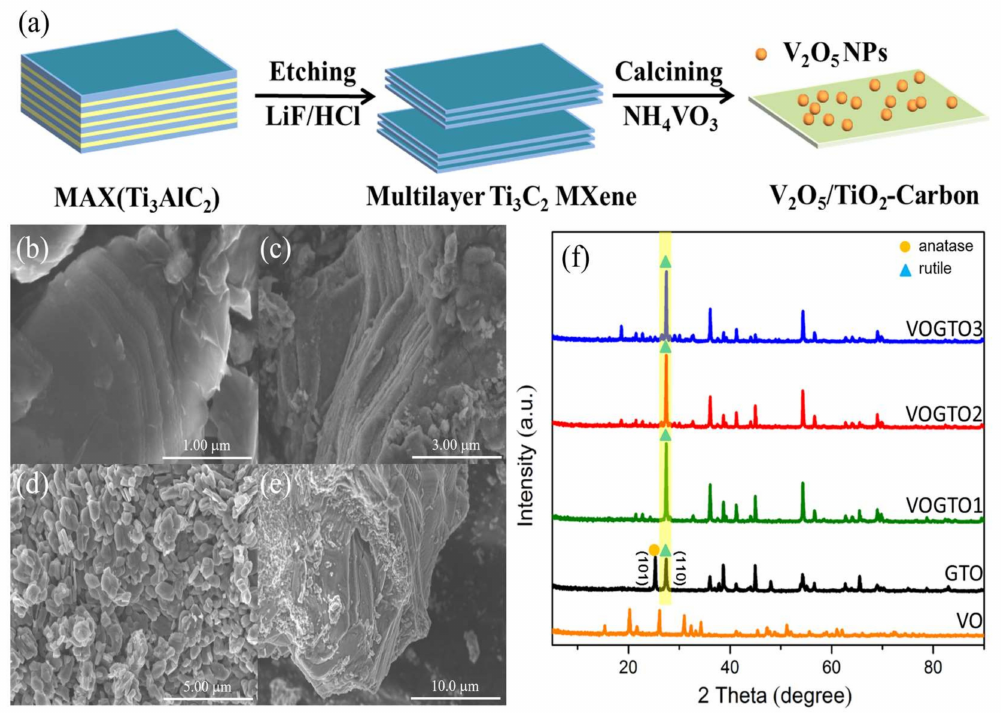
Figure 1. ( a ) Schematic procedure for the synthesis of V 2 O 5 /TiO 2 -Carbon; SEM images of ( b ) TC, ( c ) GTO, ( d ) VO and ( e ) VOGTO2; ( f ) XRD patterns of the